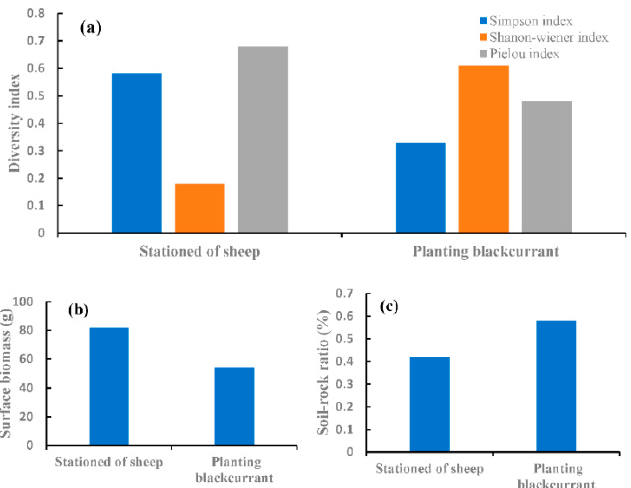
Figure 7. Effect of water replenishment measures on surface vegetation and soil restoration. Note: ( a – c ) are subtitle of Figure. ( a ) is diversity index, ( b ) is surface biomass and ( c ) is soil-rock ratio